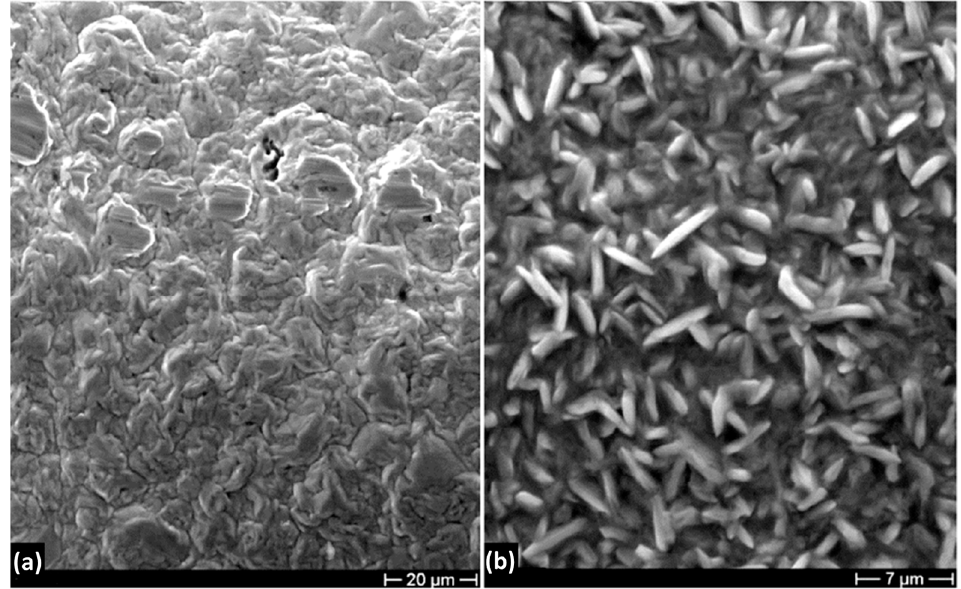
Figure 12. SEM micrographs of the Ni deposit after thermal treatment at ( a ) 170 °C and ( b ) 800